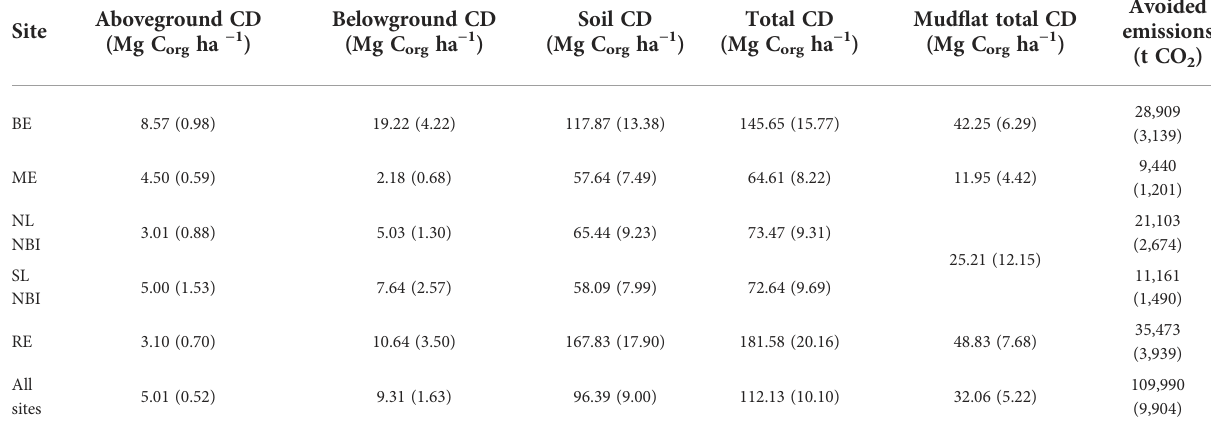
TABLE 1 Mean carbon density per hectare (A ̂ ± standard error) for each carbon pool of each site and the average across all sites.